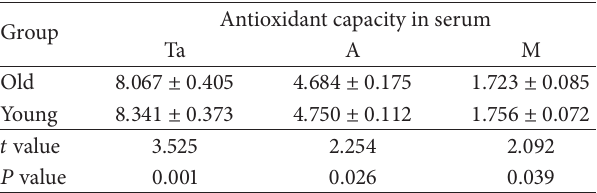
Table 1: Total antioxidant capacity (Ta), average activity (A), and mass of antioxidant substances (M) in serum of two different groups (potassium permanganate method).